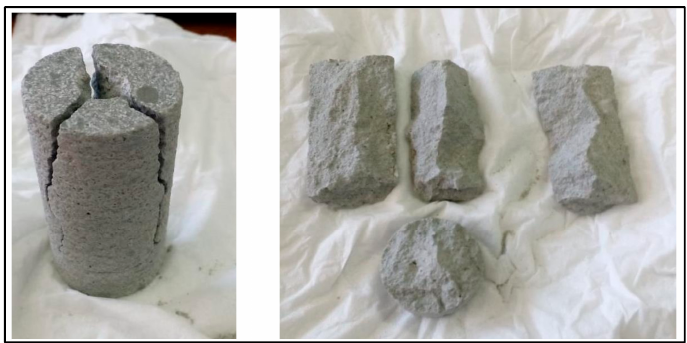
Figure 10. Fractured mortar sample after dynamic compression impact loading test (Dry Case).